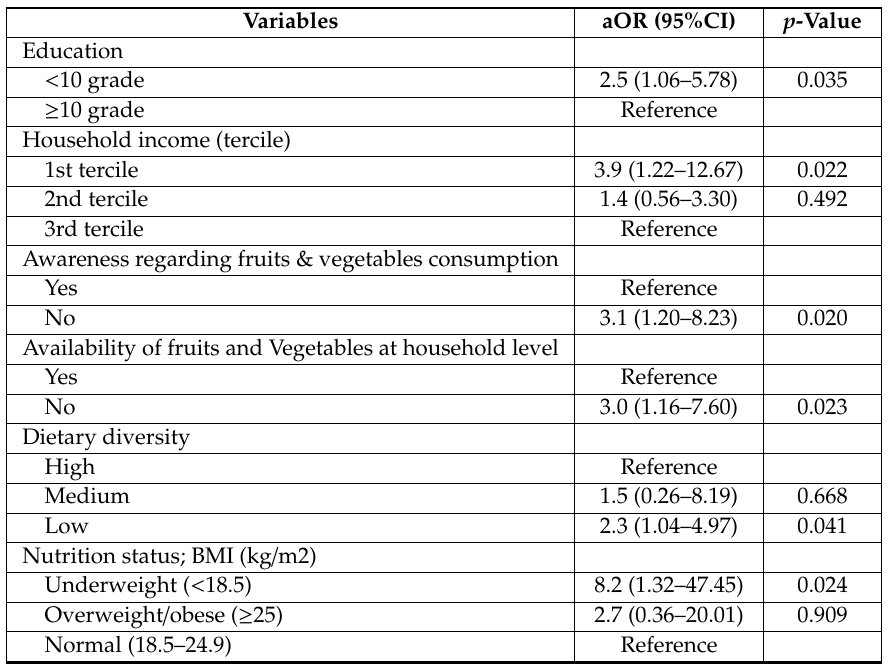
Table 3. Multivariable logistic regression analysis of socio-demographic, awareness, and dietary factors of adolescent girls with respect to fruit and vegetable consumption in rural communities in the Dhanusha district of Nepal,